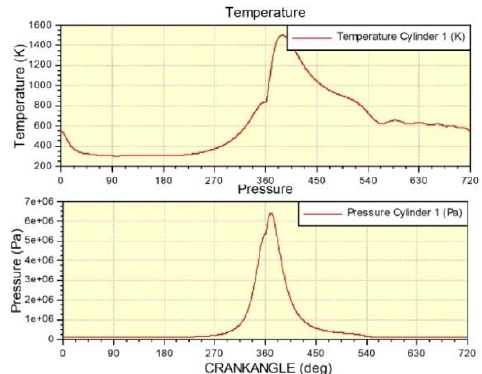
Fig. 9. In-cylinder temperature and pressure for ammonia port injection engine